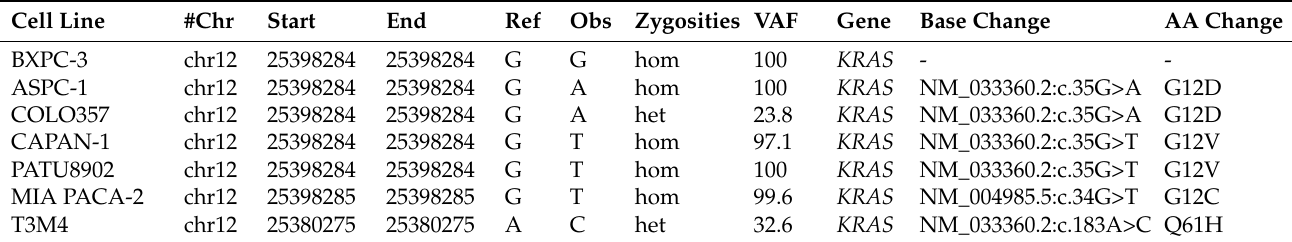
Table 2. Thereby, COLO357 and T3M4 represent the only two cell lines characterized by a heterozygotic KRAS genotype. Table 2. KRAS status of PDAC cell lines.